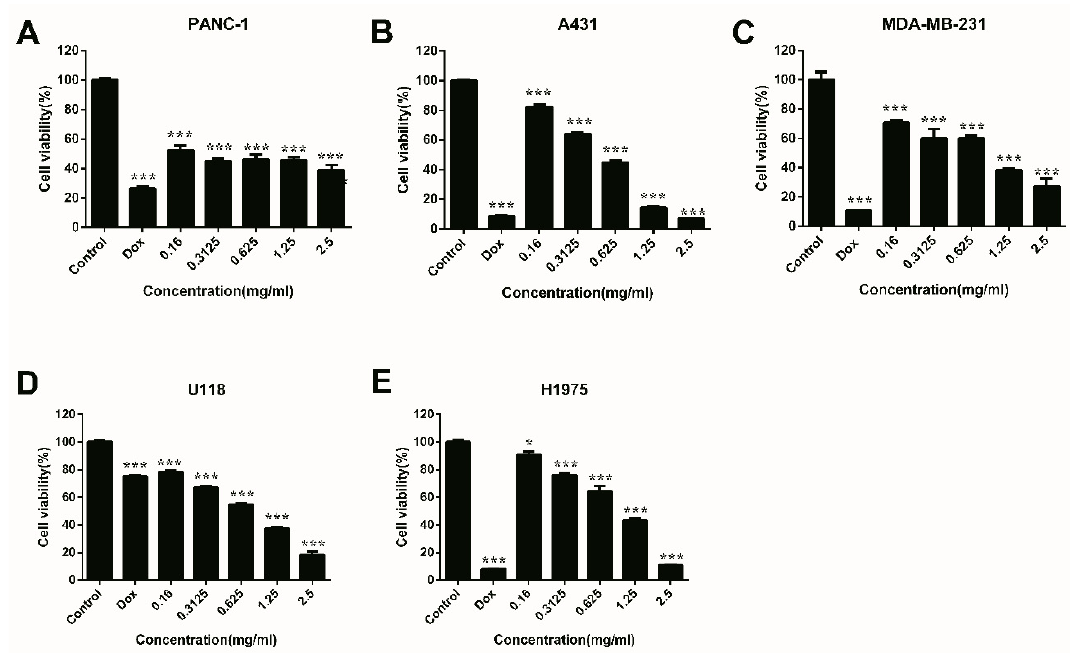
Figure 8. Anti-proliferation effects of JC-PS1 against PANC-1 ( A ), A431 ( B ), MDA-MB-231 ( C ), U118MG ( D ) and H1975 cells ( E ) with DOX as a positive reference. The data were represented as mean ± SD for triplicate, * p < 0.05; ** p < 0.01; *** p < 0.001; using the t-test.